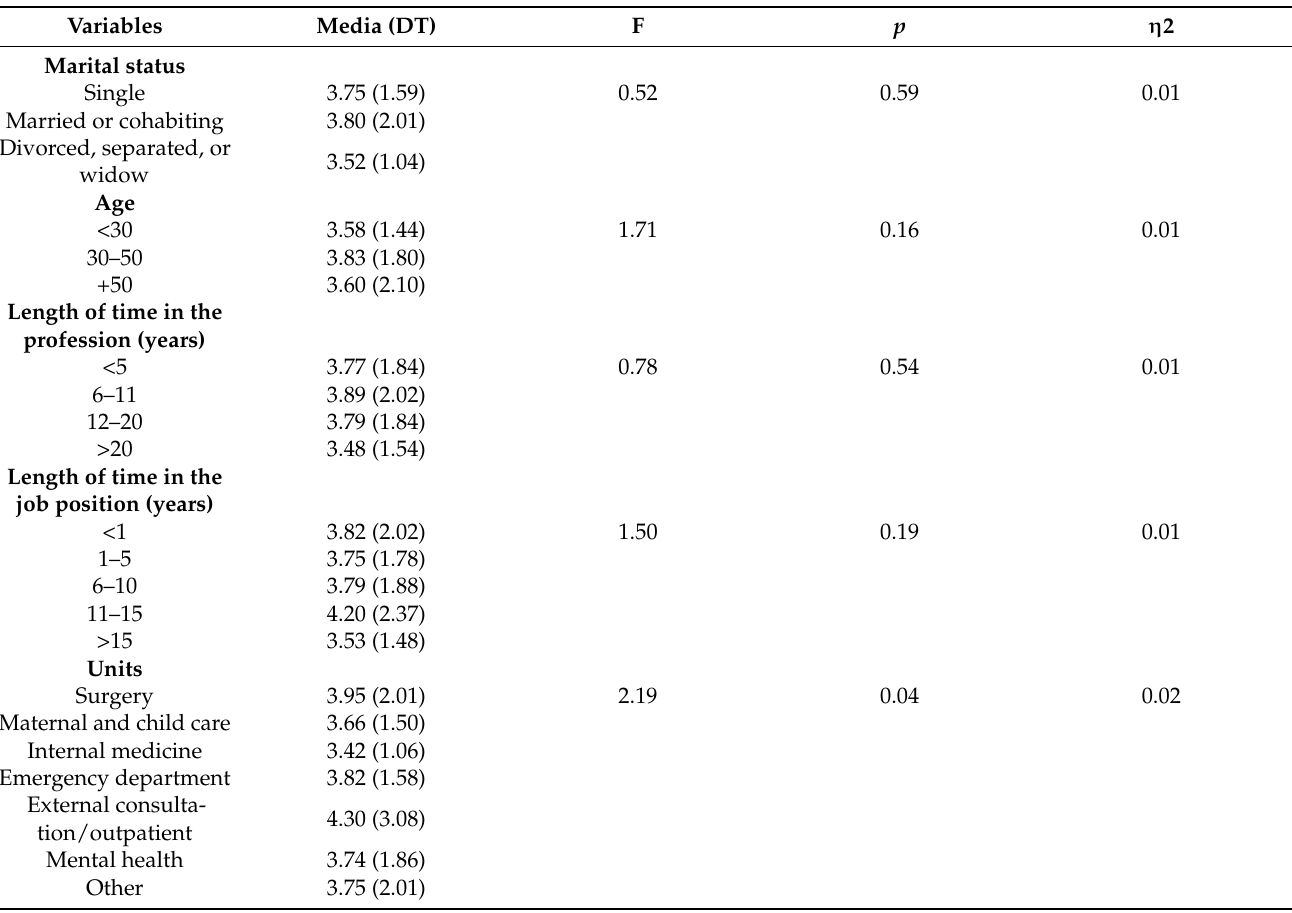
Table 5. ANOVA for social lateral violence.